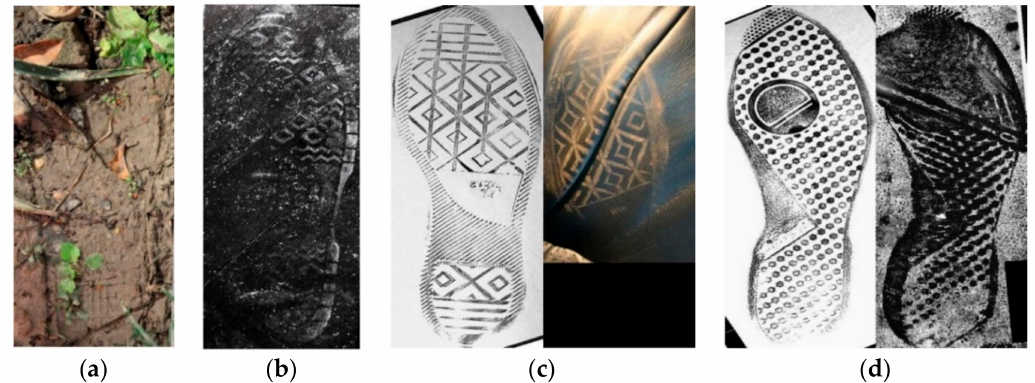
Figure 10. The properties posed by the crime scene shoeprint images: ( a ) Shoeprints are hardly distin- guished from the complicated background. ( b ) Shoeprints are randomly incomplete. ( c ) Deformations of the shoeprint can occur. ( d ) Deformation can